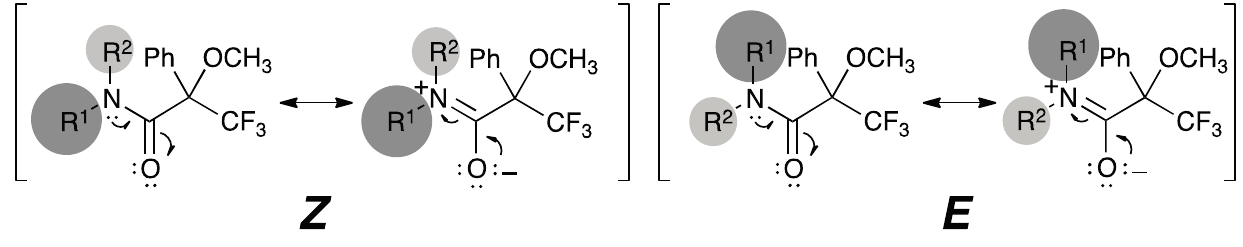
Figure 5. Histogram for the dihedral angles C1 ′ –N–C1–O1 of all MTPA amides. The α -carbon atom of substituent R sp , which is sp to the amide carbonyl group, was defined as C1 ′ . The possible range of the dihedral angle C1 ′ –N–C1–O1 is from − 90° to +90°.